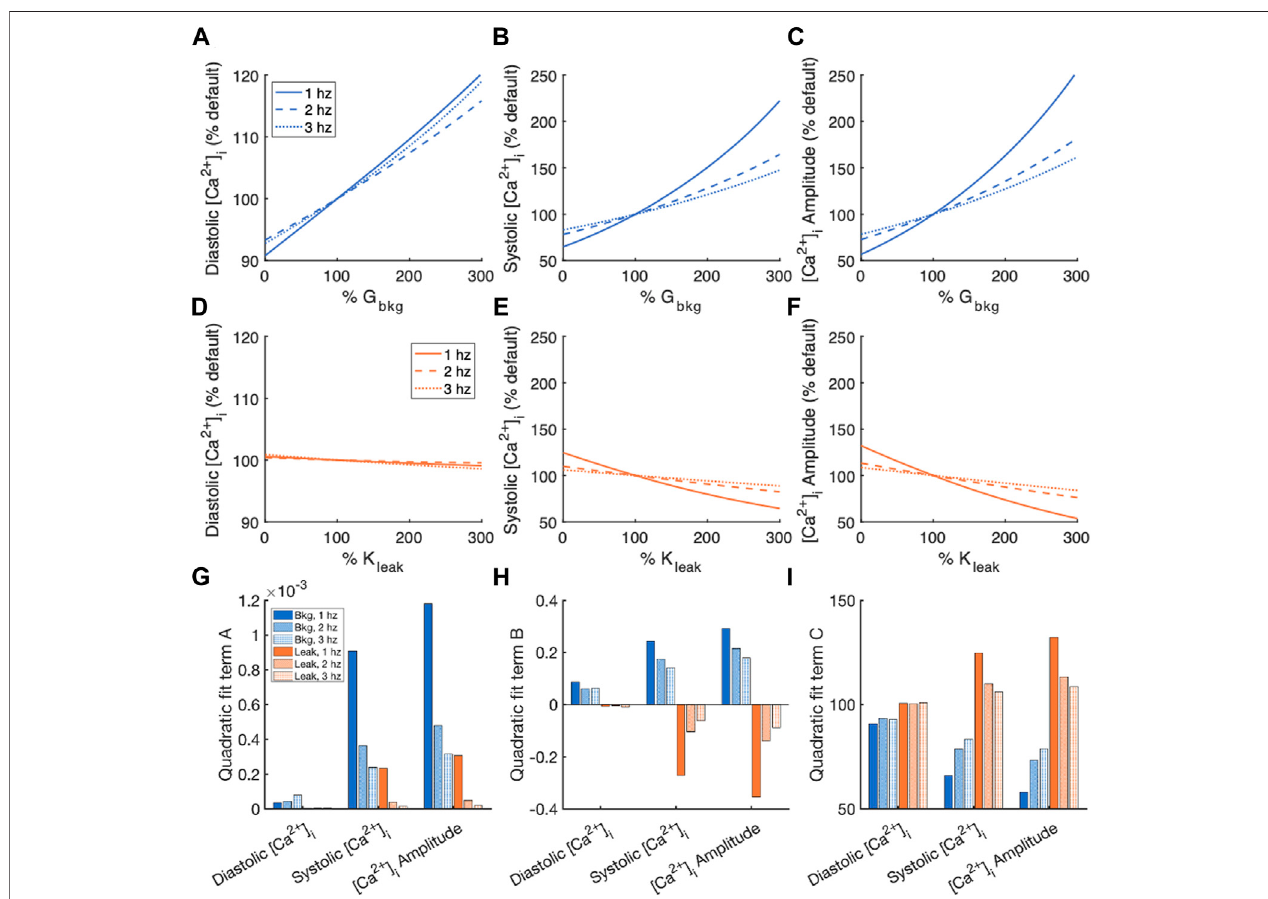
FIGURE 5 | Summary of effects of modulating G bkg or K leak independently on [Ca 2+ ] i . Sensitivity analyses of modulating G bkg on measurements of (A) diastolic [Ca 2+